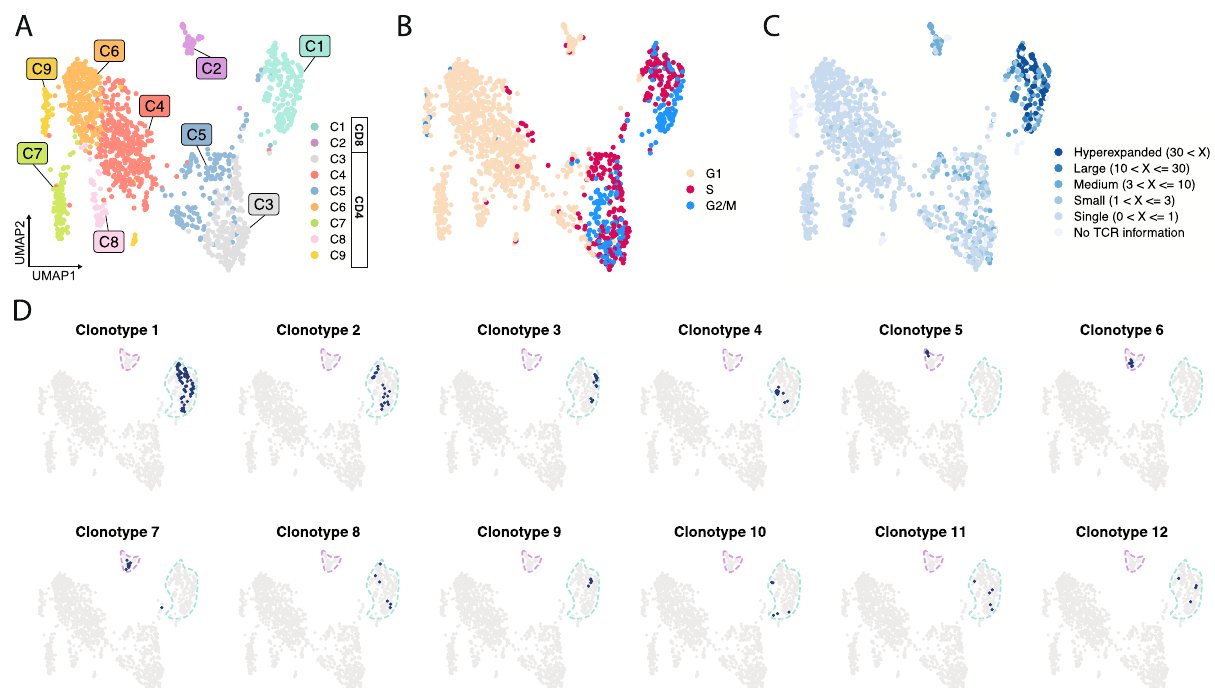
Fig. 2 | Mixed-lymphocyte reaction identi fi es highly proliferative and clonally expanded alloreactive CD8 + T cells. A Uniform Manifold Approximation and Projection (UMAP) clustering of T cells isolated from MLR. B UMAP of predicted